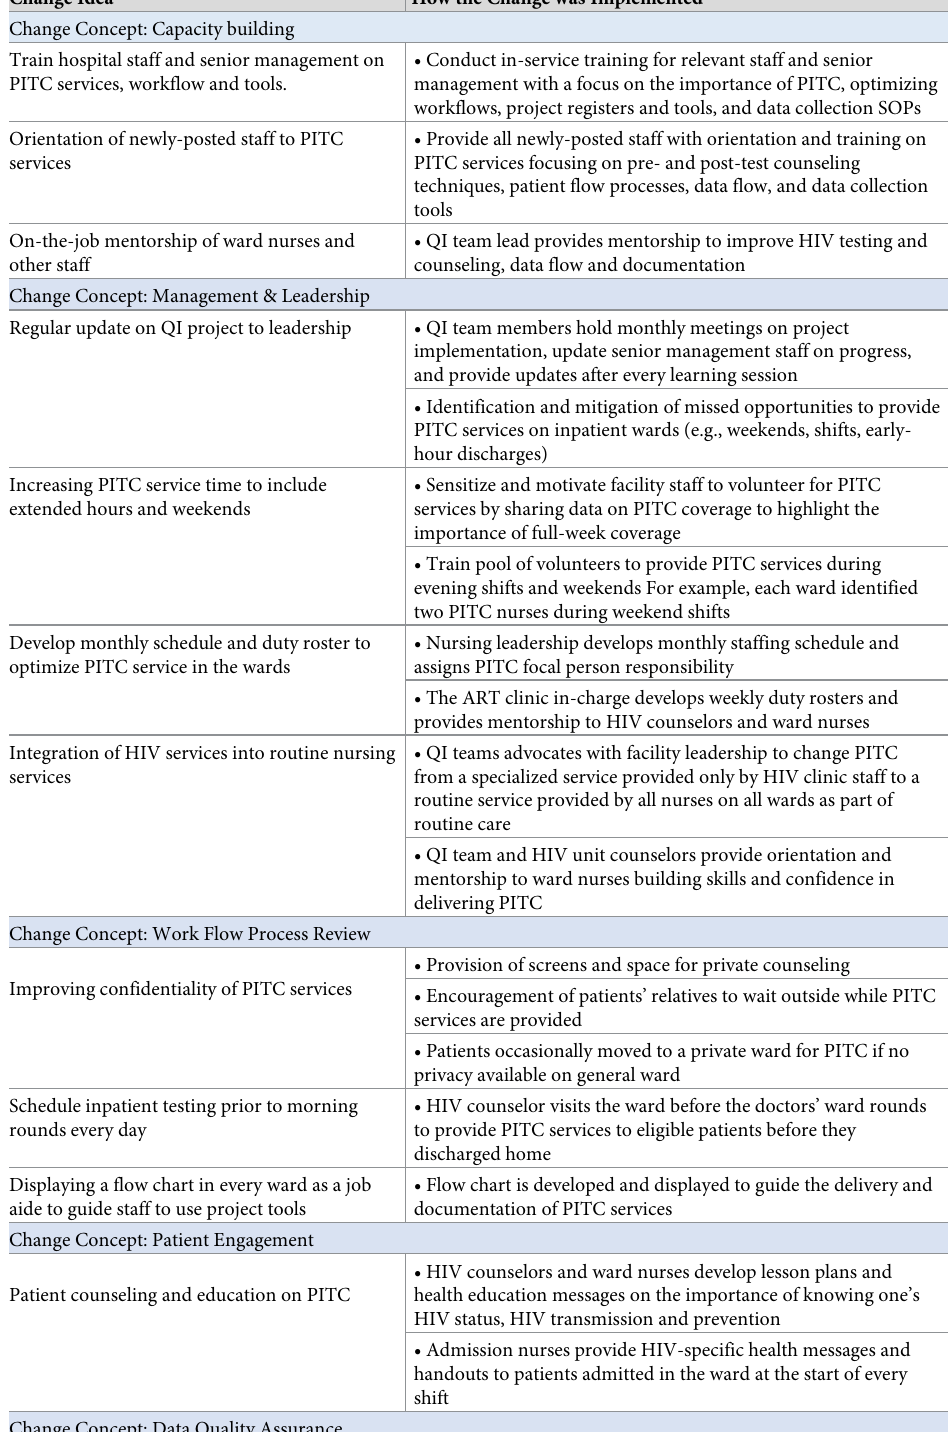
Table 2. Change package–illustrative change